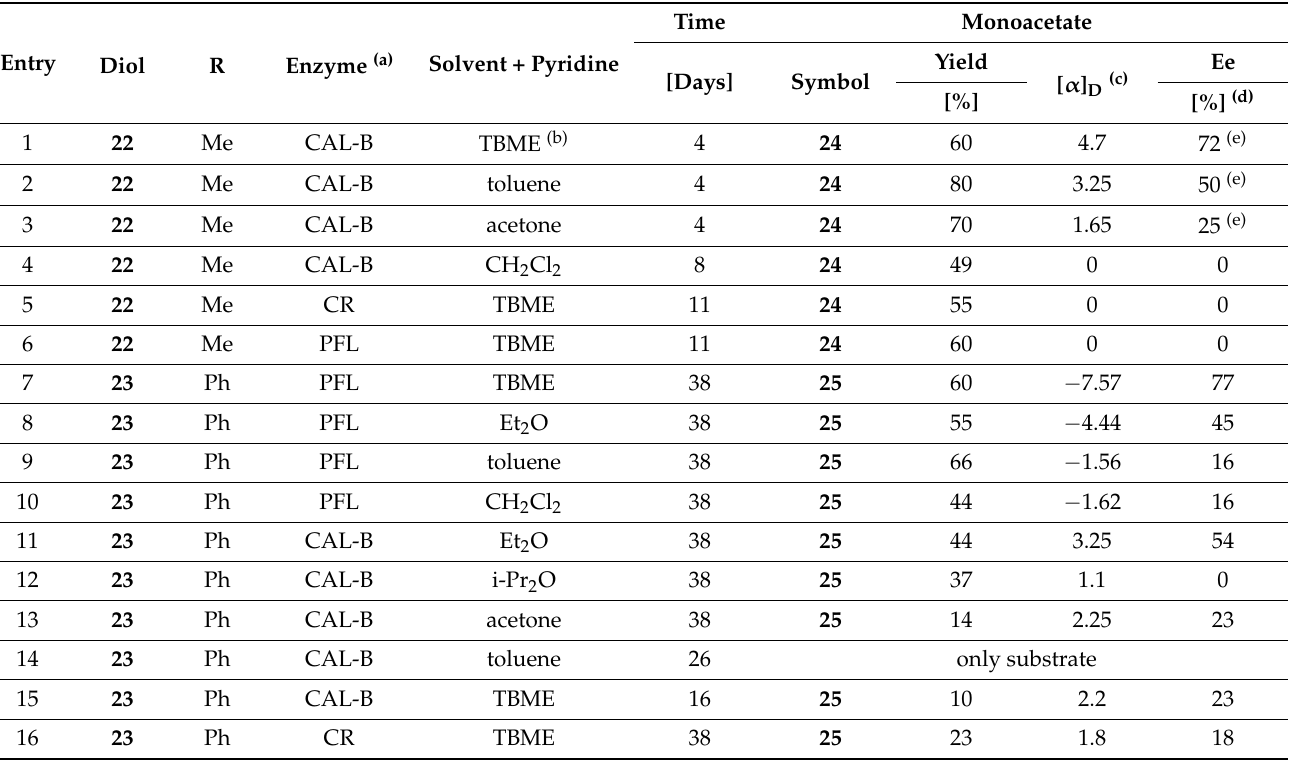
Table 2. Monoacetates 24 and 25 via desymmetrisation of bis (2-hydroxymethylphenyl)phosphine sulfides 22 and 23 . Table 2. Desymmetrisation of bis (2-hydroxymethylphenyl)phosphine sulfides 22 and